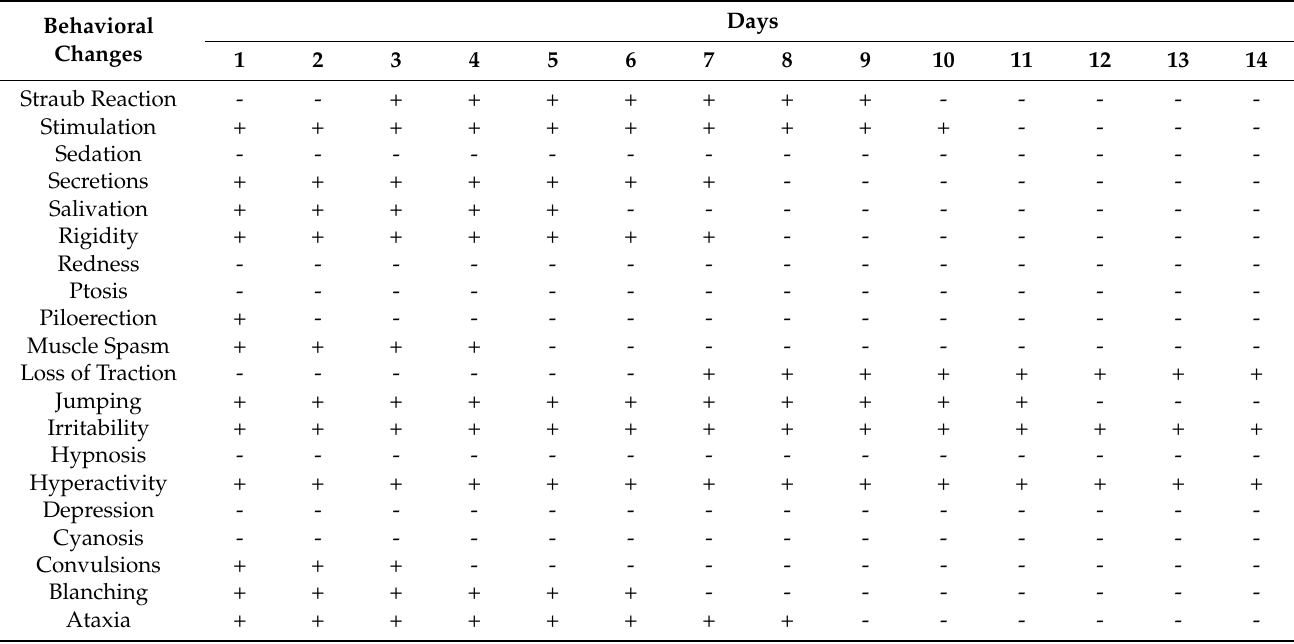
“-“Sign indicates absence of effect while “+” sign indicates the presence of